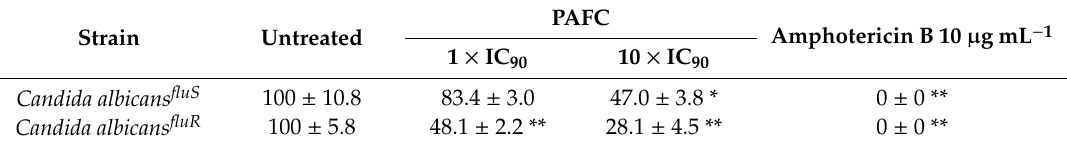
Table 2. Survival of Candida albicans sessile cells after 24 h treatment with PAFC determined by plating assay § . Strain